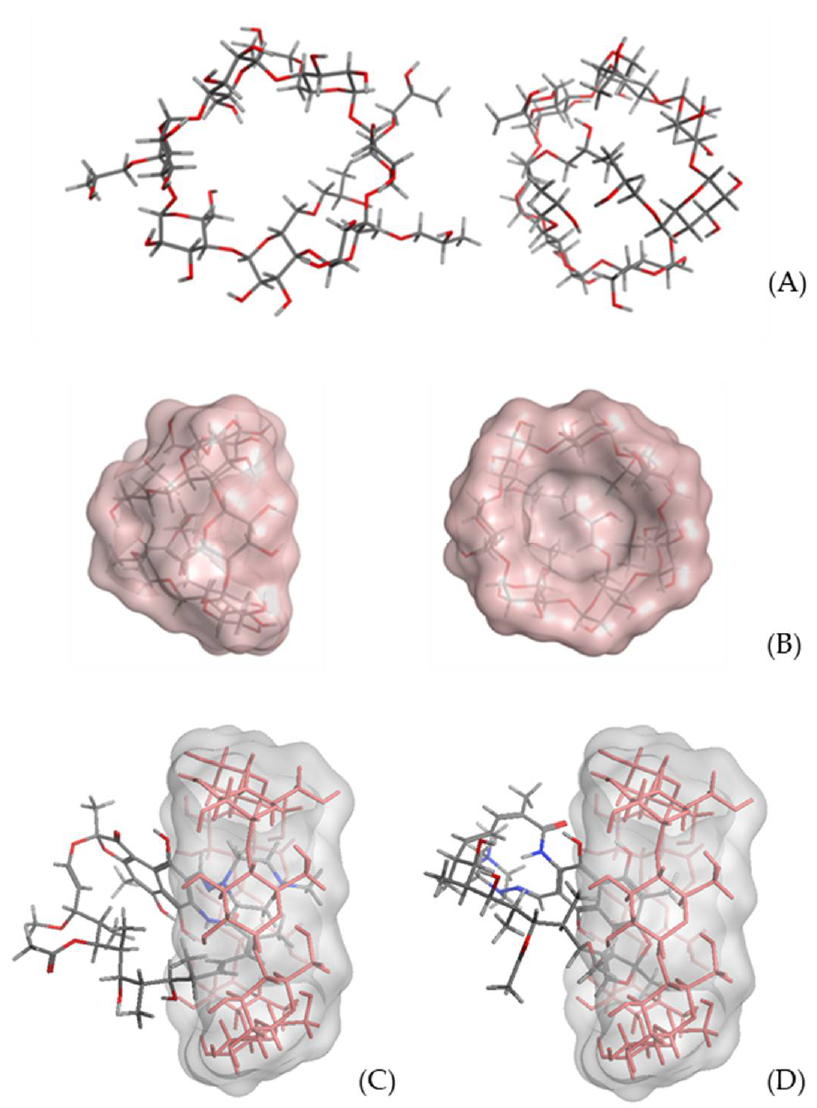
Figure 4. ( A ) Open (left) and closed (right) representative lowest energy conformation for 2HP-βCD (sticks, C = grey; H = white; O = red). ( B ) Lateral and frontal (mayor face) perspective for closed conformation (molecular surface). Representative best poses for RIF- ɣ CD complexes. ( C ) N-(4- methylpiperazin-1-yl)methanimine moiety placed in the inner cavity. ( D ) Bezo[f]benzofuran-3-one moiety placed in the inner cavity.